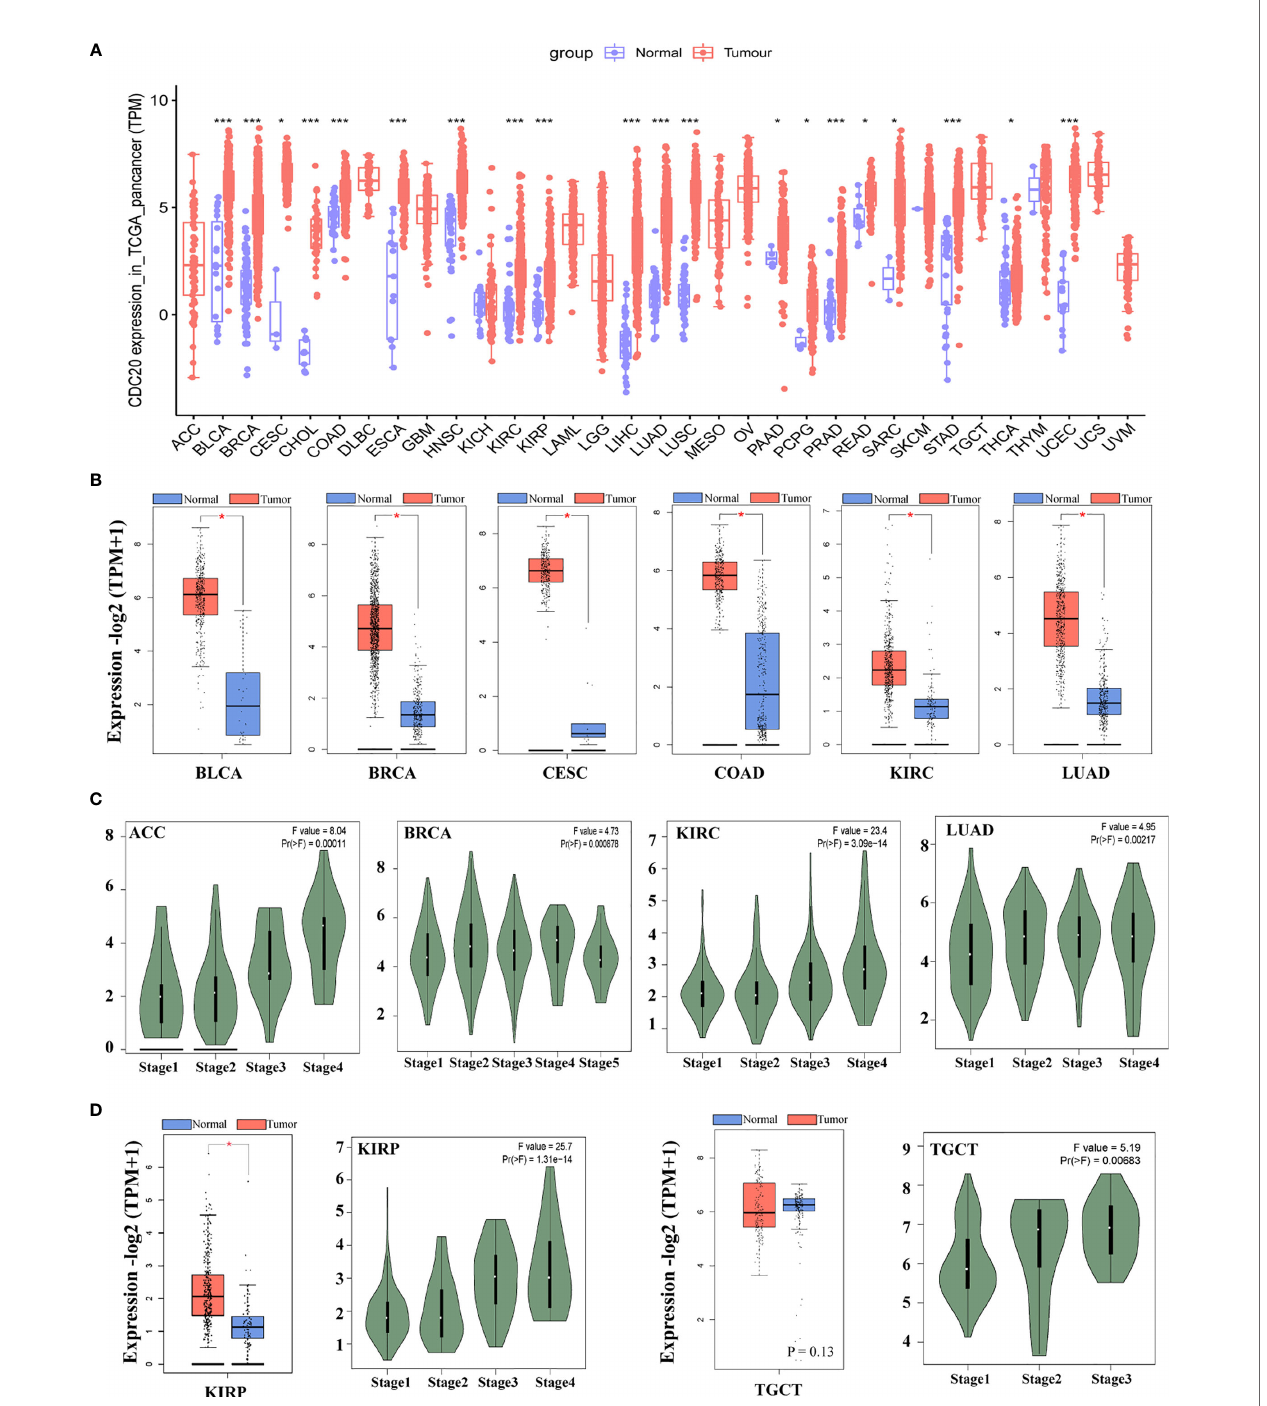
FIGURE 1 | The mRNA expression of CDC20 gene in different types of TCGA tumors and different pathological stages. (A) The mRNA expression levels of the CDC20 gene in different types of cancers and corresponding normal tissues or speci fi c cancer subtypes from TCGA were statistically analyzed by R version 4.0.3. *P < 0.05; ***P < 0.001. (B) Box-plots of mRNA expression for representative cancers (BLCA, BRCA, CESC, COAD, KIRC, LUAD) with signi fi cantly elevated CDC20 expression in malignant tissues according to the TCGA pan-cancer dataset. Besides, expression data of normal tissues from GTEx were included as normal controls. (C) The mRNA levels of the CDC20 gene were analyzed by clinical stages (stage 1, stage 2, stage 3, and stage 4) of ACC, BRCA, KIRC, and LUAD. Log 2 (TPM+1) was used for log-scale. (D) The mRNA levels of the CDC20 gene were analyzed by clinical stages (stage 1, stage 2, stage 3, and stage 4) of KIRP and TGCT. Log 2 (TPM+1) was used for